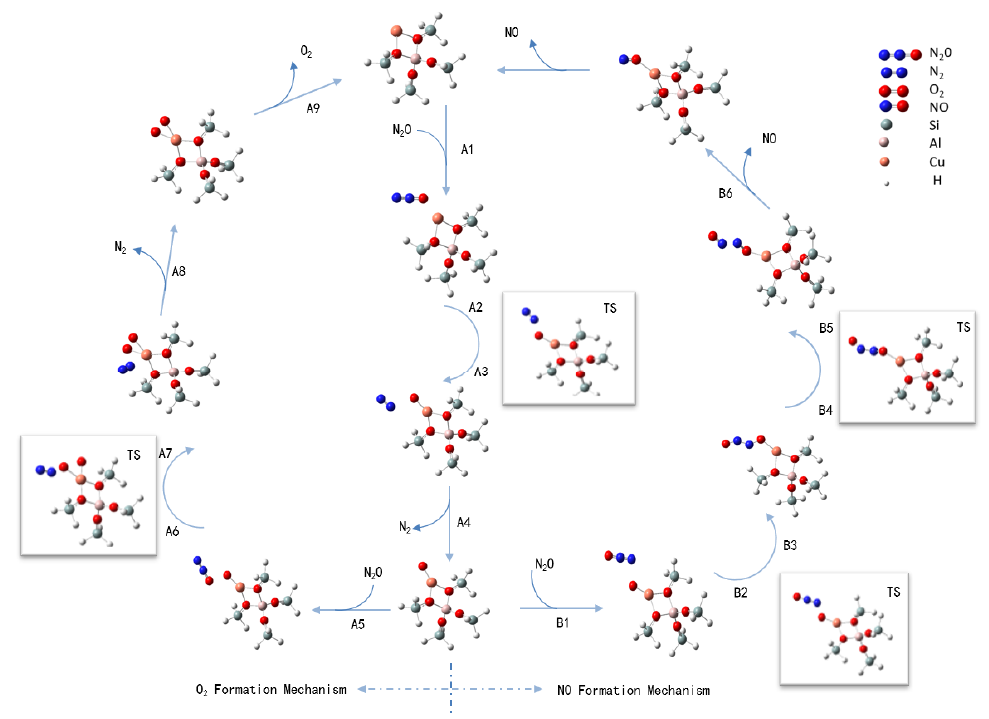
Figure 1. Optimized models and the schematic diagrams of the reaction steps of the two mechanisms.